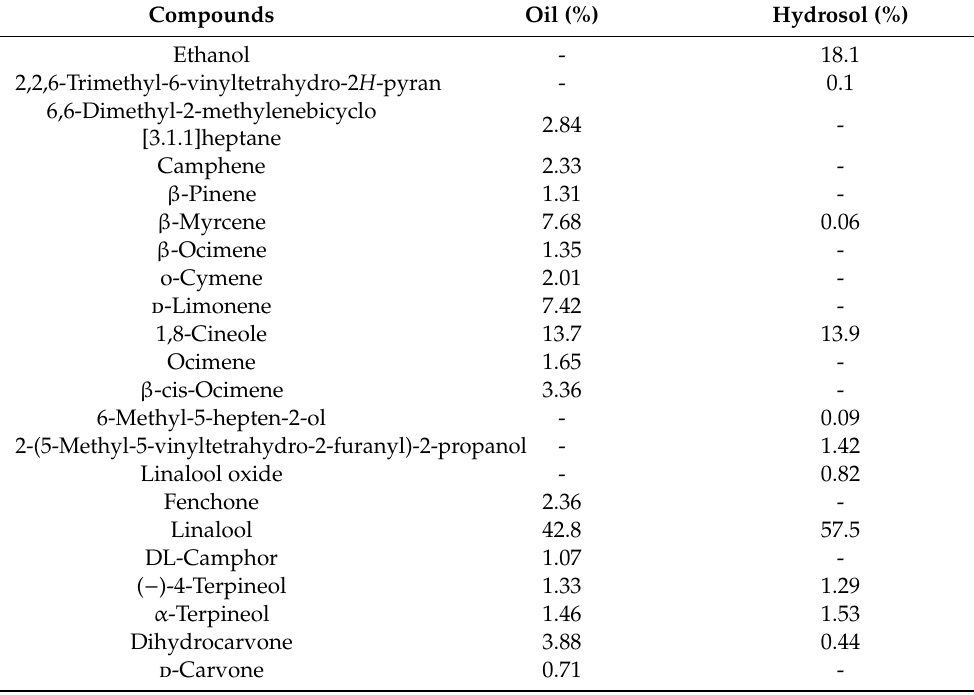
Table 1. Chemical composition of kuromoji essential oil and hydrosol.